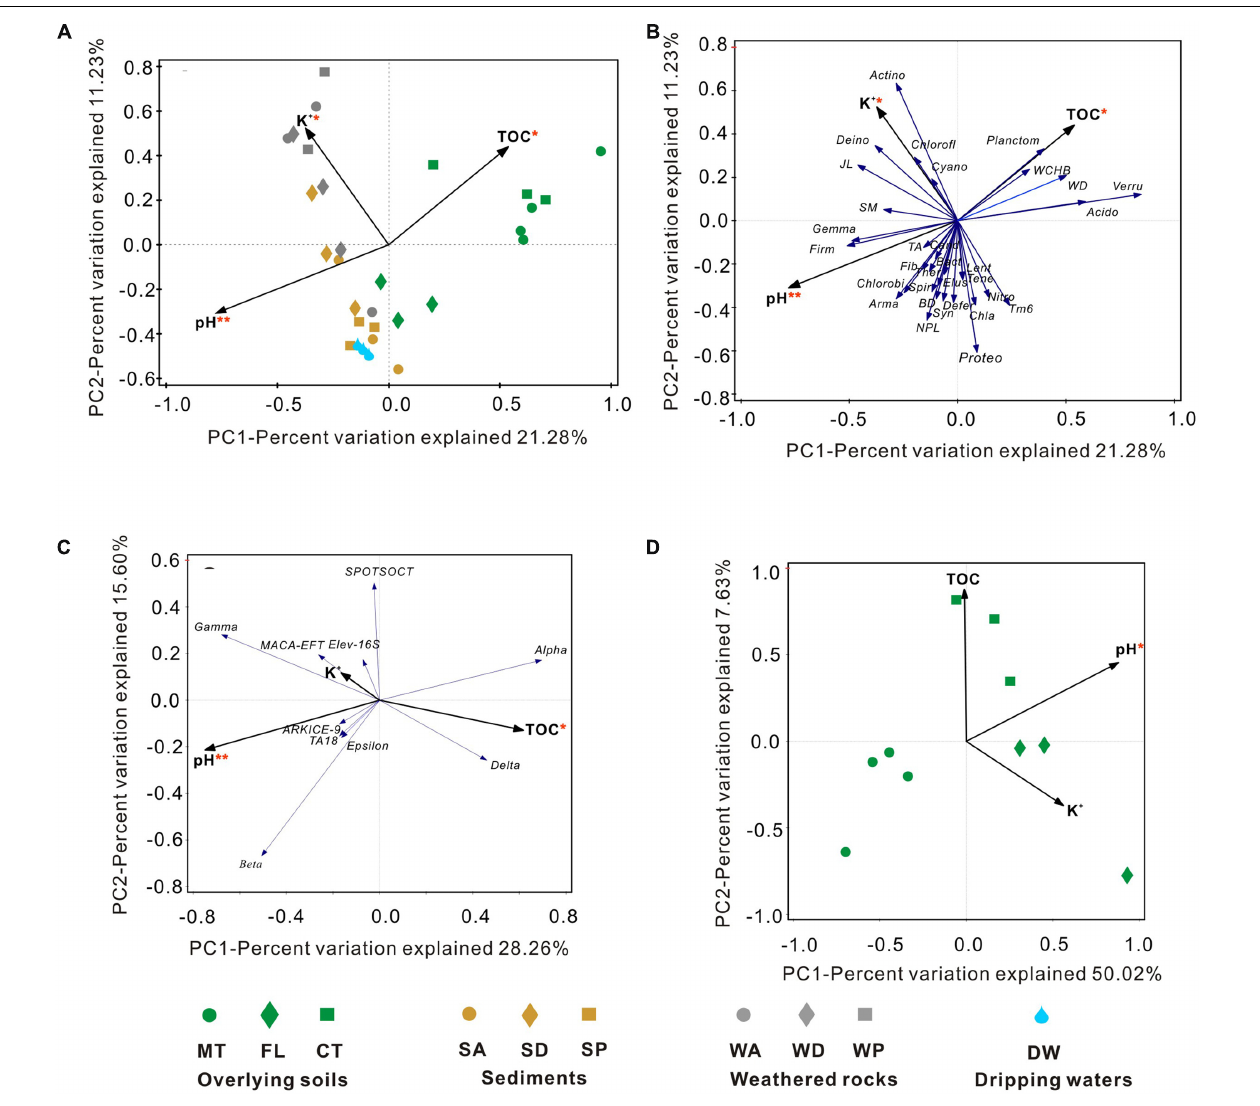
FIGURE 8 | Redundancy analysis (RDA) of 16S rRNA gene data and environmental factors at the phylum level (A,B) and the class level in Proteobacteria (C) among the whole cave ecosystem, and at the phylum level only among overlying soils (D) . The environmental factors with p -values < 0.05 and p -values < 0.01 are marked with one red asterisk and two red asterisks, respectively. Environmental factors in gray indicate the lack of significant effects on the bacterial community structure. Sample abbreviations are described from Figure 1 . Actino, Actinobacteria; Proteo, Proteobacteria; Acido, Acidobacteria; Chlorofl, Chloroflexi; Planctom, Planctomycetes; Bact, Bacteroidetes; Gemma, Gemmatimonadetes; Nitro, Nitrospirae; Verru, Verrucomicrobia; Firm, Firmicutes; Cand, Misc. Candidate Division groups; JL, Candidate Division JL-ETNP-Z39; Ther, Thermotogae; Cyano, Cyanobacteria; Defer, Deferribacteres; Arma, Armatimonadetes; Chla, Chlamydiae; Lent, Lentisphaerae; Deino, Deinococcus-Thermus; TA, Candidate Division TA06; WCHB, Candidate Division WCHB1-60; SM, Candidate Division SM2F11; BD, Candidate Division BD1-5; Fib, Fibrobacteres; NPL, Candidate Division NPL-UPA2; Syn, Synergistetes; Spir, Spirochaetae; Elus, Elusimicrobia; Tene, Tenericutes; WD, Candidate Division